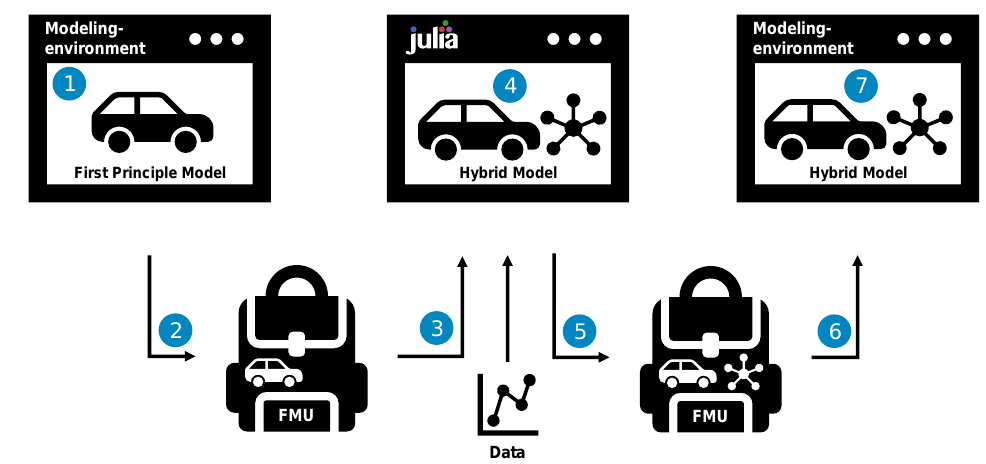
Figure 4. Workflow of the presented hybrid modeling application using a modeling tool that supports FMI (export and import) and FMI.jl together with FMIFlux.jl